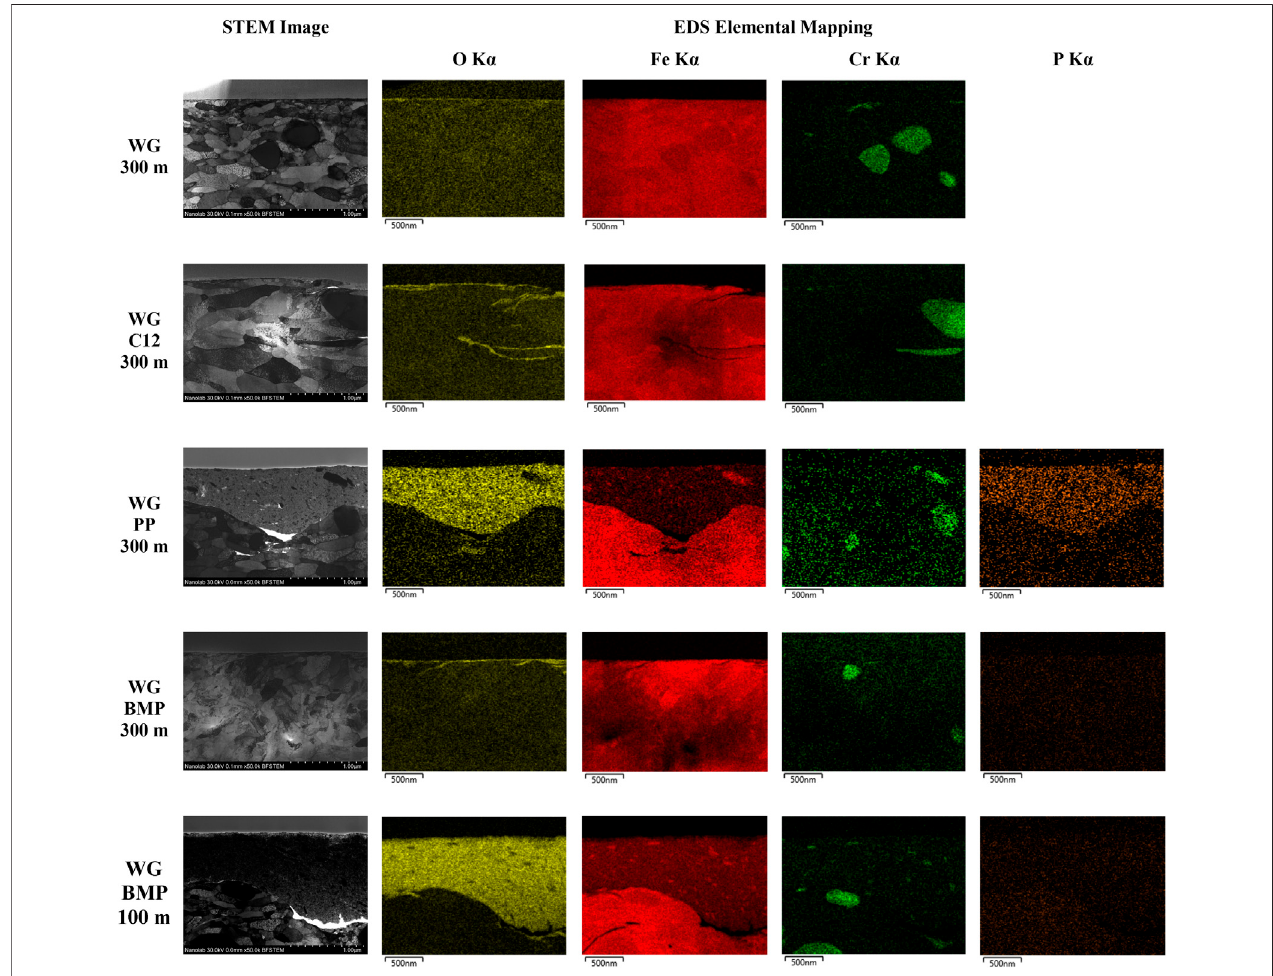
FIGURE5| STEMcross-sectionimagesandEDSelementalmappingoftheweartracksonAISI52100steeldisktestedindifferentlubricantsatroomtemperature.